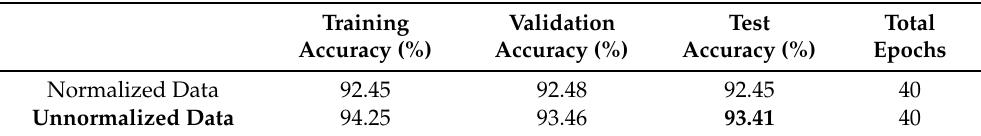
Table 4. Performance analysis of normalization on Model 5 on the RAP v2 dataset.